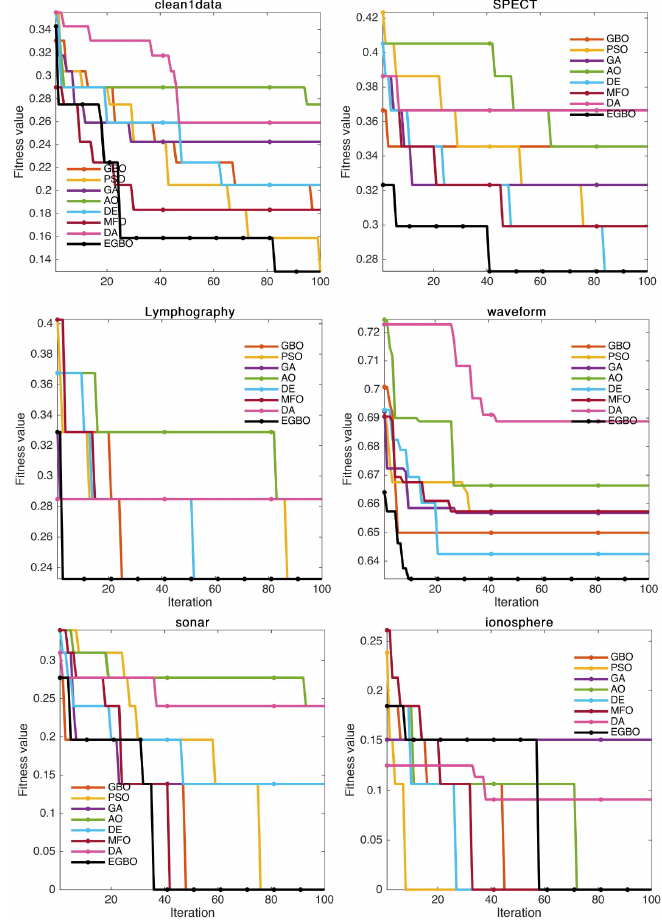
Figure 5. Example of the convergence curves for the proposed EGBO and the compared methods.